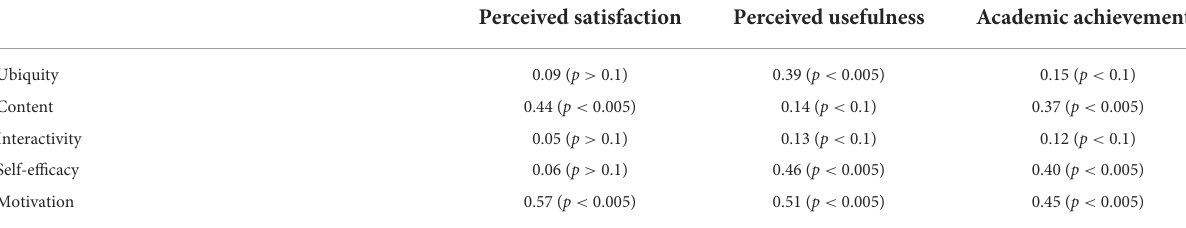
TABLE 1 The impact of various characteristics and aspects of mobile learning.